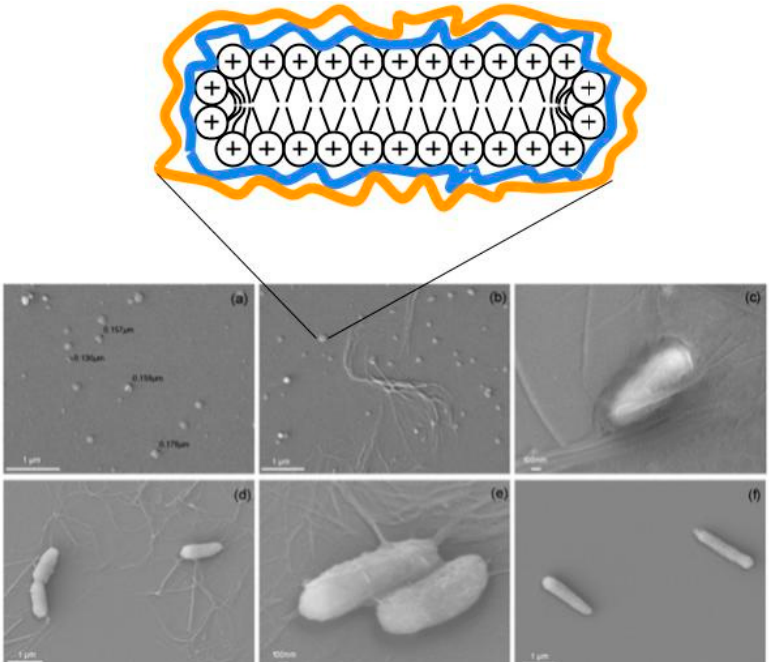
Figure 1. The interaction between Pseudomonas aeruginosa multidrug resistant (MDR) cells and bioactive supramolecular assemblies (BSA) made of dioctadecyldimethylammonium bilayer (DODAB) nanodisks surrounded by carboxymethylcellulose (CMC) in blue and poly (diallyl dimethyl ammonium) chloride (PDDA) in orange. ( a ) Scanning electron microscopy SEM ) image of BSA. ( b ) SEM image of BSA and P. aeruginosa MDR cells at 4.4 × 10 3 cells/mL. ( c ) SEM image of BSA and P. aeruginosa MDR cells at 8.9 × 10 5 cells/mL ( d ), and ( e ) SEM images of PDDA (1.0 mg/mL) and P. aeruginosa MDR cells at 8.9 × 10 5 cells/mL. ( f ) Control of P. aeruginosa MDR cells only. Final concentrations in the BSA